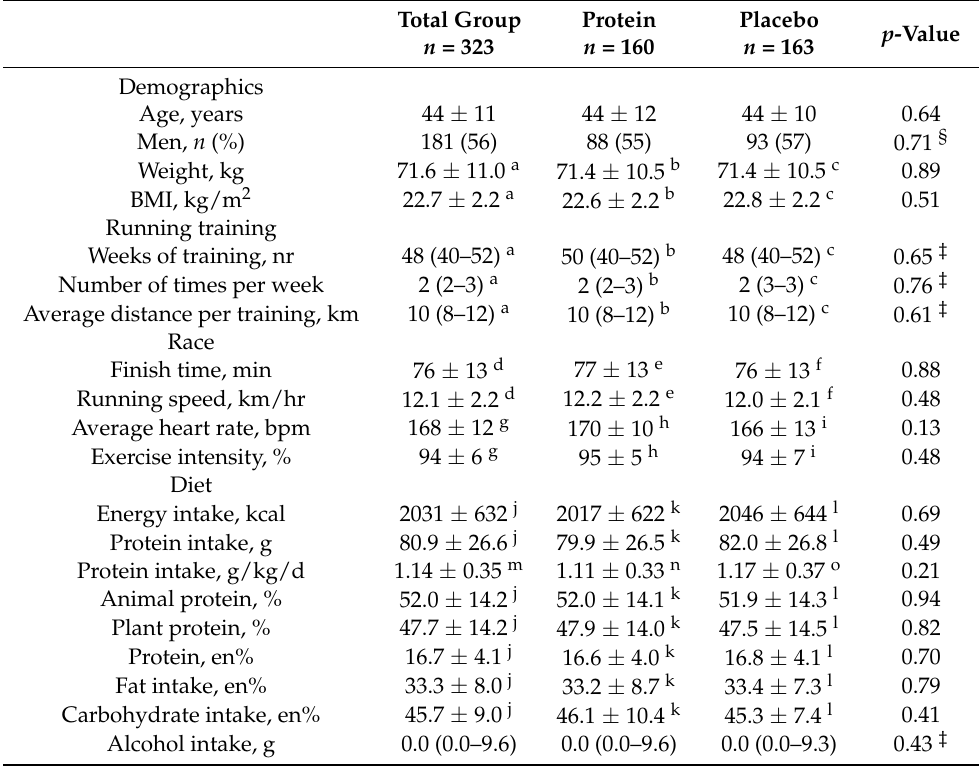
Table 1. Baseline characteristics, based on ITT.